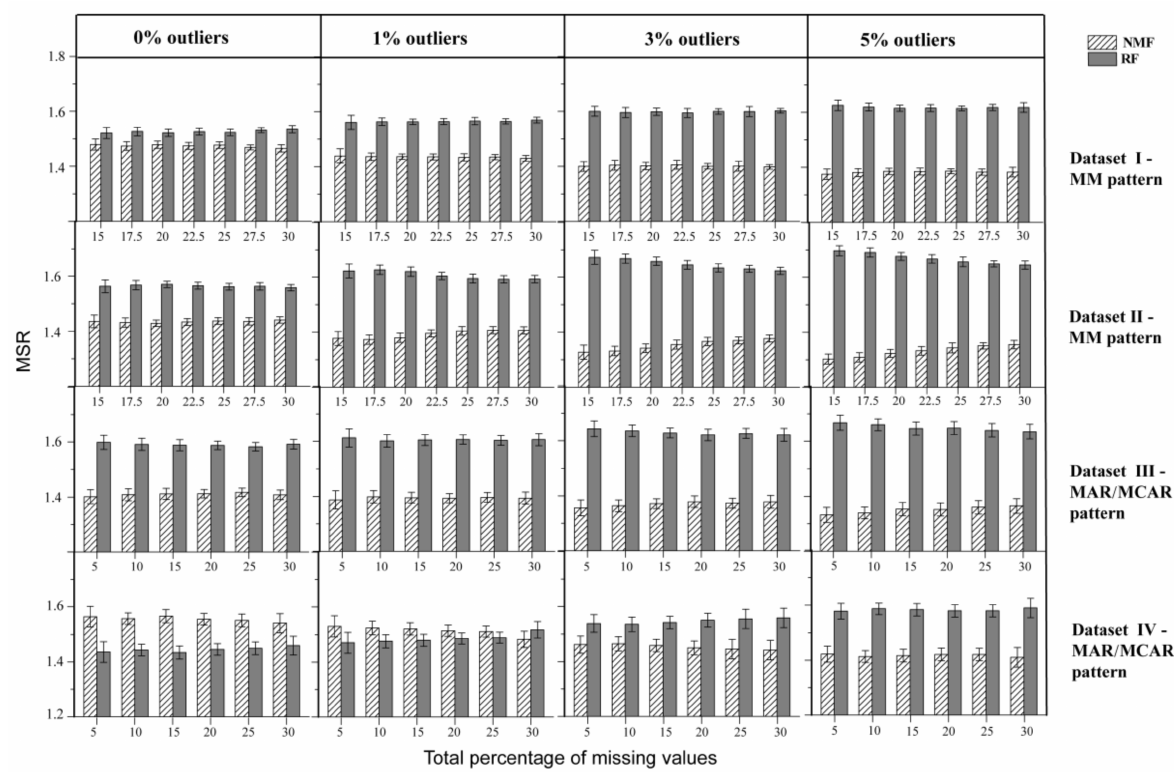
Figure 5. MSR for comparing the performance of NMF and RF on four datasets in the absence and presence of